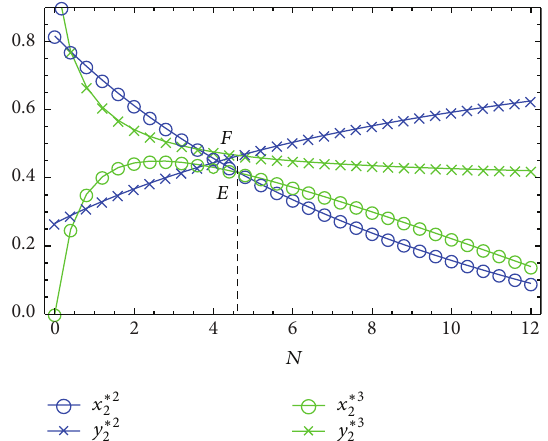
Figure 8: The changes of 𝑥 ∗ 2 and 𝑦 ∗ 2 as 𝑁 changes in compensation mechanisms 1 and 2.